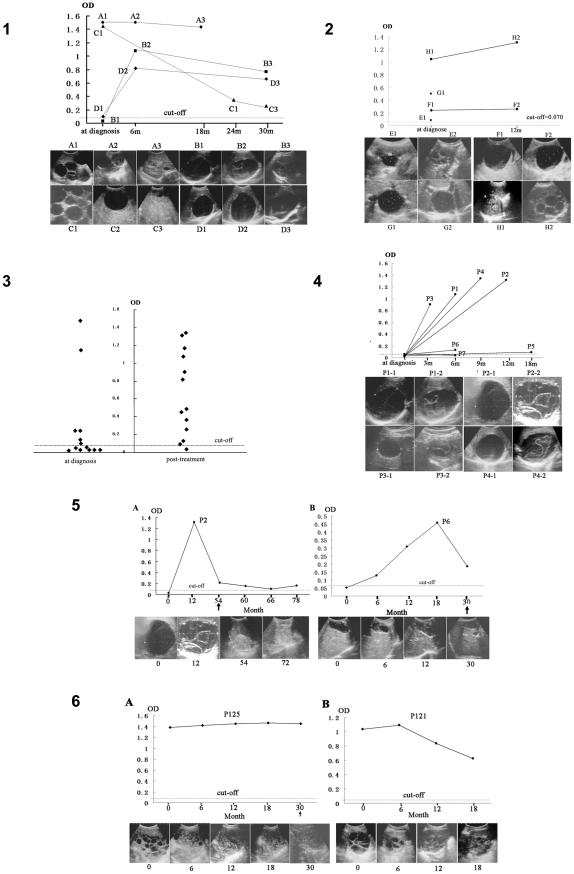
Changes of images and serum antibody levels against rAgB in CE cases during albendazole therapy.
1. Patients with regular treatment. (A): Hepatic CE2 was cured after 18 months treatment (A-1: at diagnosis; A-2: 12 months; A-3: 18 months). (B): Hepatic CE1 was cured following 30 months treatment (B-1: at diagnosis; B-2: 6 months; B-3: 30 months). (C): CE2 was improved in abdominal cavity following 42 months treatment (C-1: at diagnosis; C-2: 36 months; C-3: 42 months). (D): Hepatic CE1 was aggravated following 30 months treatment (D-1: at diagnosis; D-2: 6 months; D-3: 30 months). 2. Patients with poor compliance of treatment. (E): Hepatic CE (E-1: CL type cyst at diagnosis; E-2: CE3 type cyst with daughter cyst at 30 months). (F): Hepatic CE (F-1: CE1 type cyst at diagnosis; F-2: unchanged cyst at 12 months). (G): Hepatic CE (G-1: CE1 type cyst at diagnosis; G-2: the unchanged cyst at 6 months). (H): Hepatic CE (H-1: CE3 type cyst at diagnosis; H-2: CE2 type cyst at 12 month). Patient E and G refused to donate blood samples when followed up. 3. ELISA OD values in 13 CE1 cases before and after treatment (3 months to 18 months). 4. In seven CE1 cases (P1-P7) with seronegative response at diagnosis, six (P1-P6) converted to be seropositive following 3 months to 18 months treatment. Concurrently the cyst changed to CE3a from CE1 type in all these six cases. 5. In two albendazole-cured CE1 cases, specific antibody levels were initially elevated and subsequently declined during treatment, but remained positive when CE was cure. 6. In two albendazole-cured or improved CE2 patients, (A): stability of specific antibody levels in a cured CE2 case; (B): initial elevation followed by subsequent decline of specific antibody levels in an improved CE2 patient. The arrow referred to the time when CE was found to be cured.